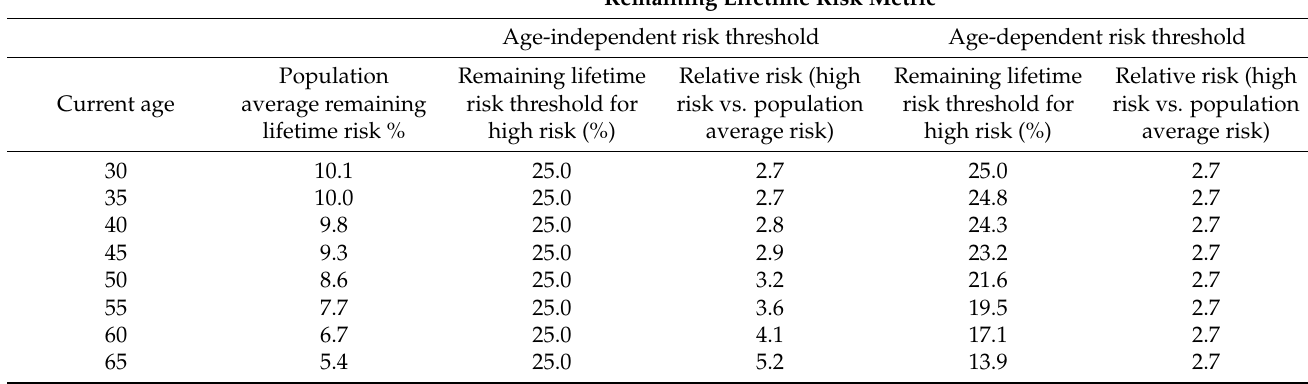
Table 2. Age-specific relative risks associated with age-independent and age-dependent absolute risk thresholds for the high-risk category compared to the population average absolute risk, using remaining lifetime risk and 10-year absolute risk for breast cancer in women in Canada (2012–